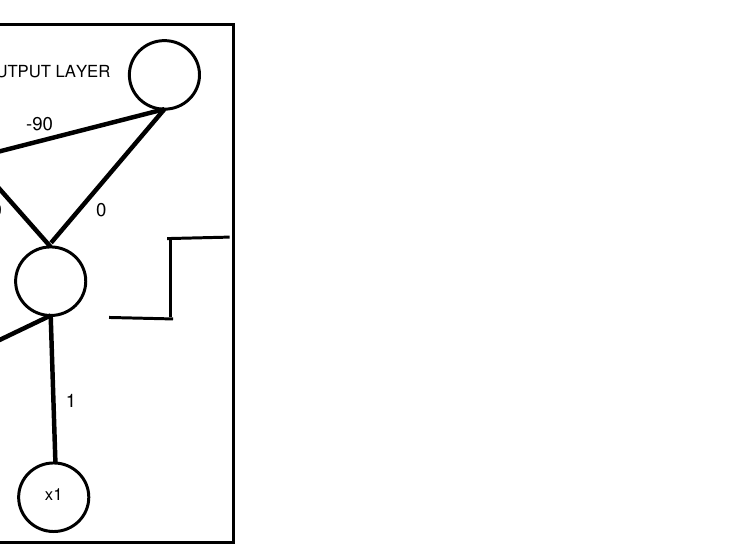
Figure 3. An interpretable MLP coding a propositional rule with a unique antecedent ( x 1 > t 1 ) .